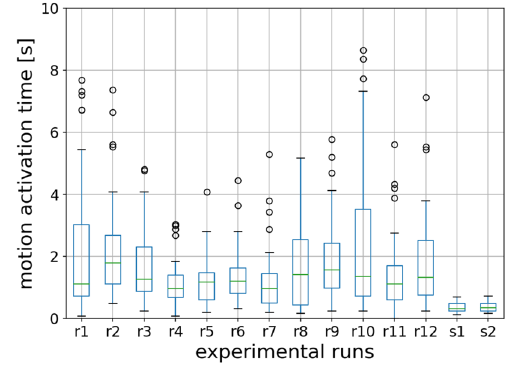
Figure 9. The distribution of motion activation time of children and university students in different experimental runs. r for the experimental run of children’s experiment and s for that of students’. The circles represent the outliers.